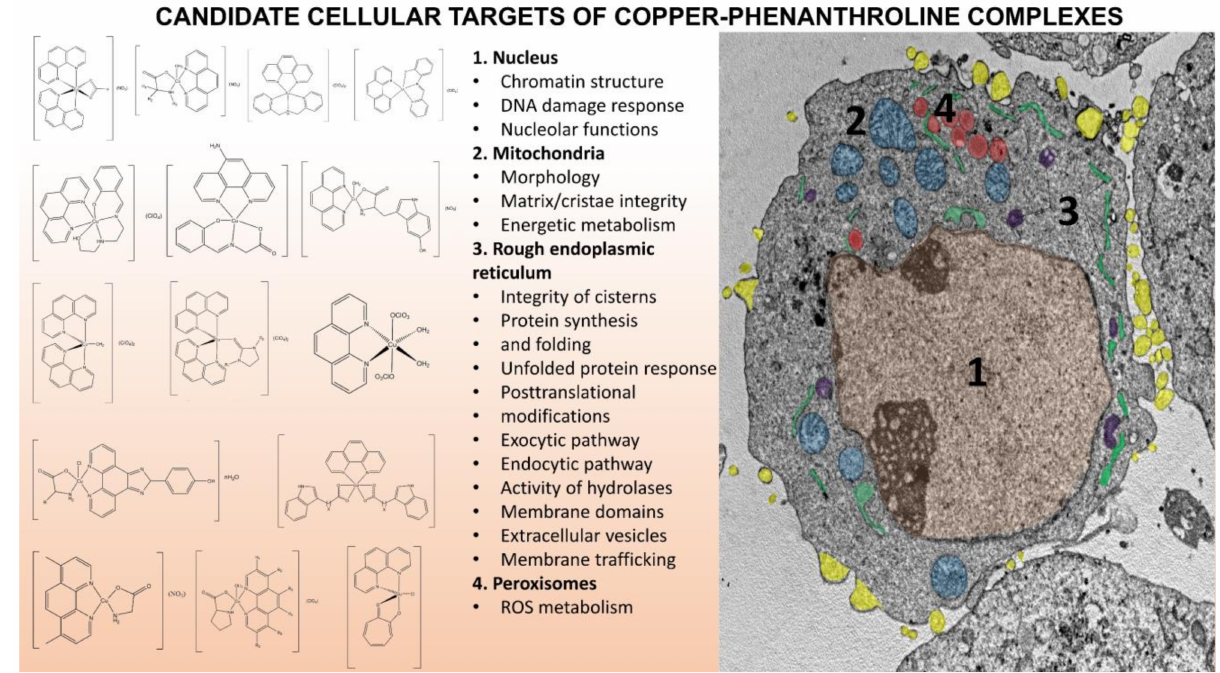
Figure 29. The candidate cellular structures and molecular mechanisms interfering with copper-phen complexes visualized in the A-2780 cancer